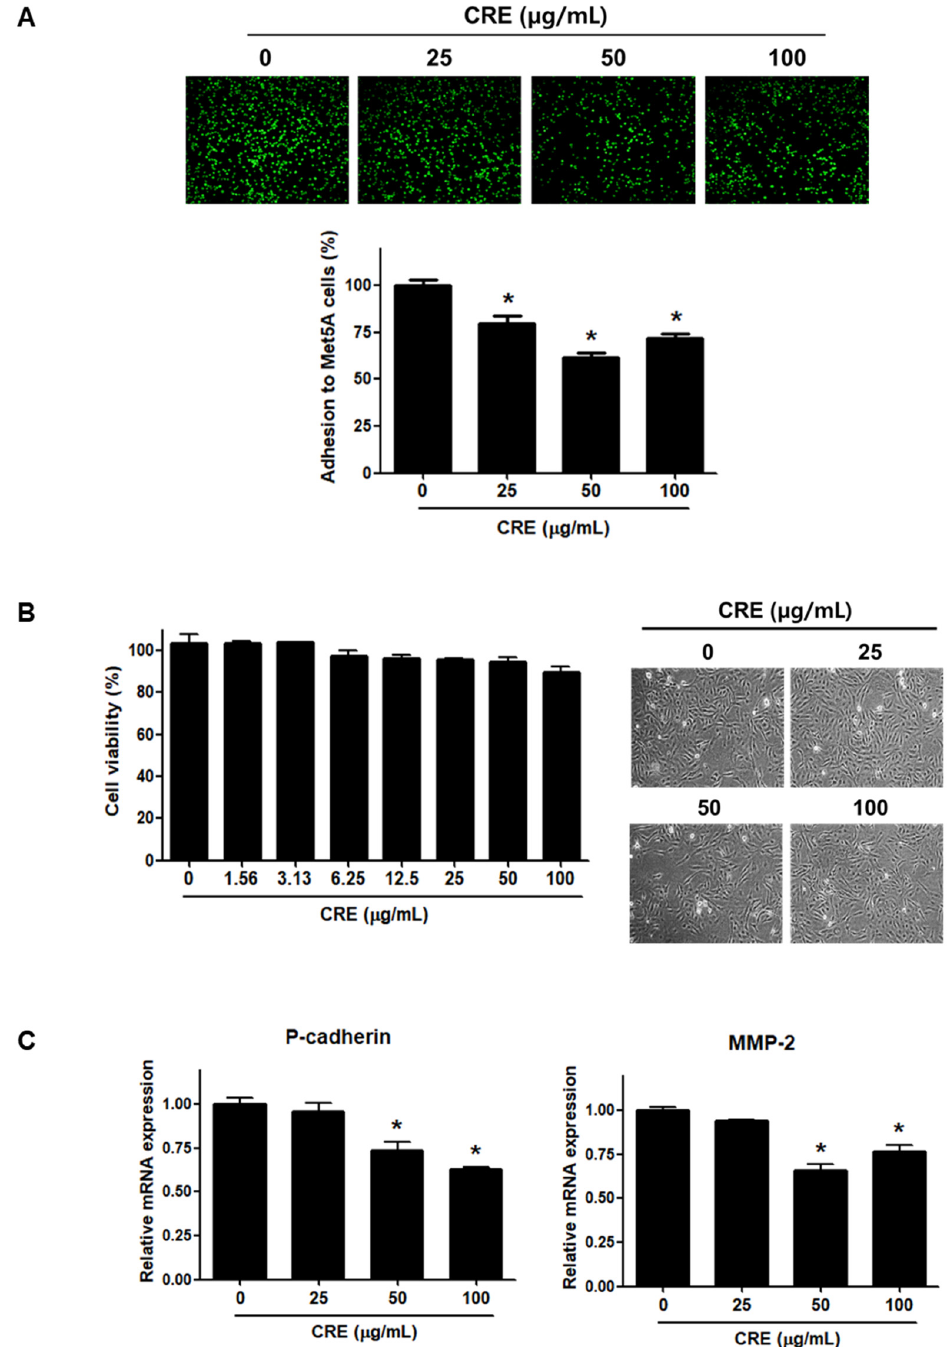
Figure 1. Effect of CRE on endometriotic cell adhesion to mesothelial cells and expression of adhesion molecules in endometriotic cells. ( A ) Human endometriotic cells (12Z) were treated with CRE at indicated concentration (25, 50 and 100 µg/mL) for 24 h. The 12Z cells labeled with CellTracker TM (10 µM) were cultured on Met5A cell layers in a 96-well plate for 1 h. The total fluorescence in each well was measured by fluorescence microphotography. ( B ) Cell viability was determined by MTT assay. Representative images show the cell morphology of 12Z cells treated with CRE at indicated concentration (25, 50 and 100 µg/mL) for 24 h. ( C ) The mRNA expression of P-cadherin and MMP-2 was measured by real-time RT-PCR. All expression levels were normalized to GAPDH. Results are the combined data (mean ± SD) from three independent experiments. * p < 0.05 compared with control group.